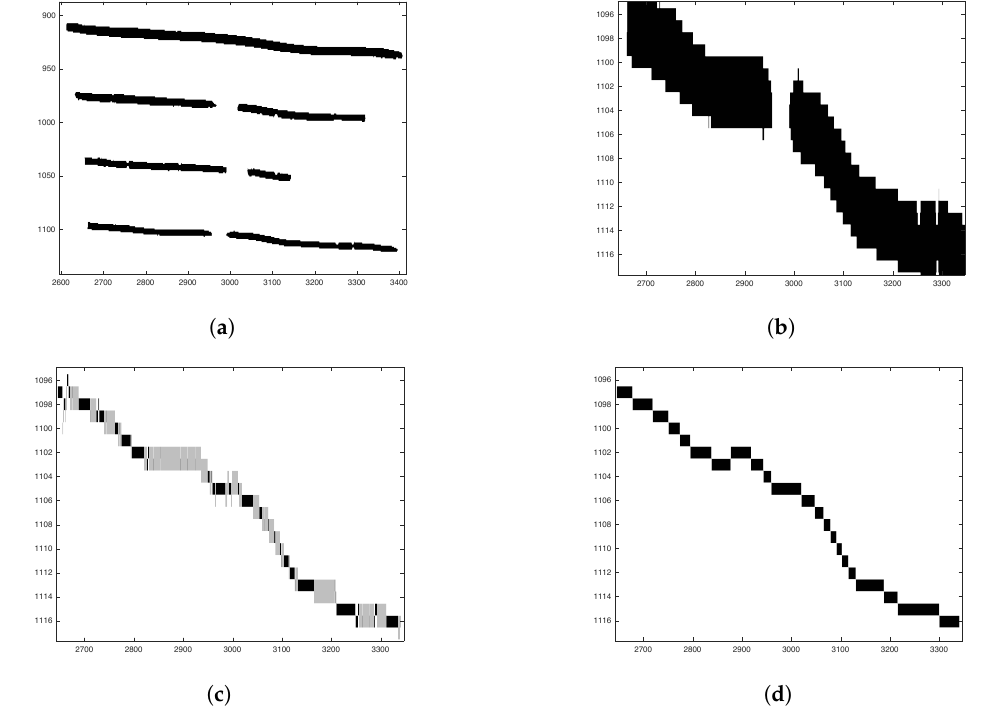
Figure 7. Illustration of the performance of the smoothing procedure. ( a ) Detail of the first staff of the original binary image corresponding to folio 2r. ( b ) Detail of the lowest staff line of ( a ). ( c ) Detail of the tracked and interpolated staff line for the image in ( b ). ( d ) Detail of the smooth reconstructed staff line for the image in ( b ).